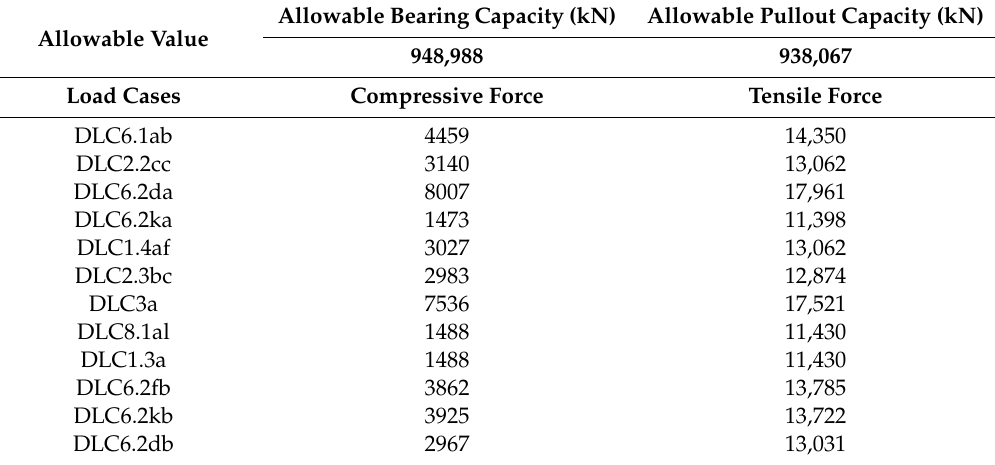
Table 8. Allowable capacities and loads of the piles.